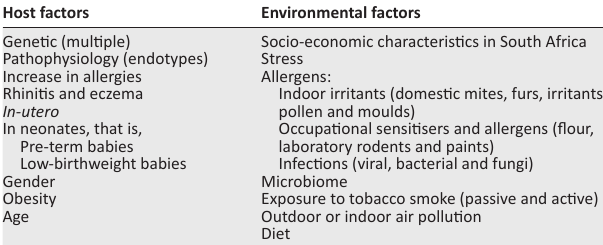
TABLE 2: Determinants of risk networks underlying severe asthma phenotypes, South